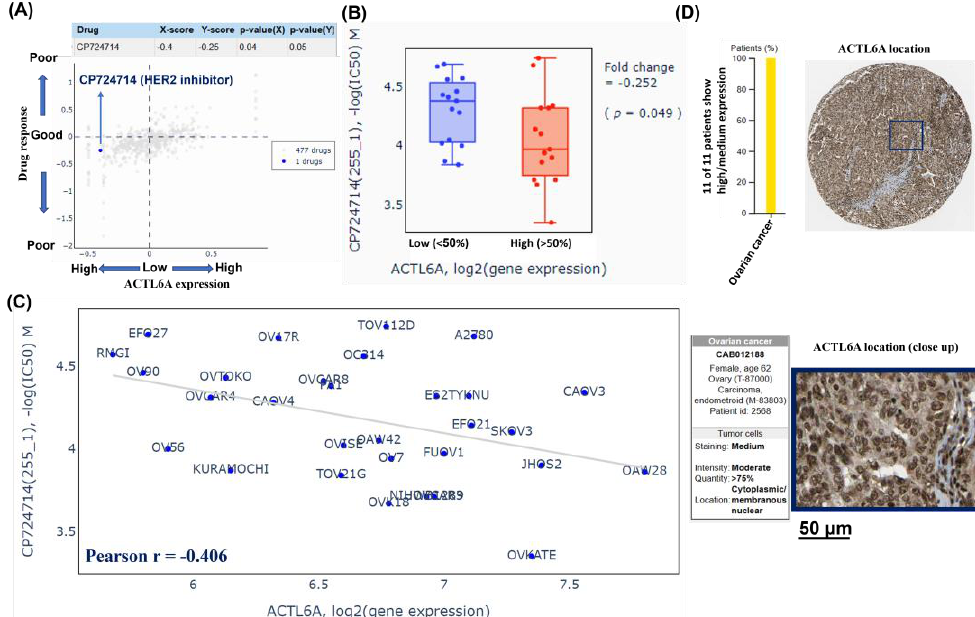
Figure 4. CP724714 as a therapeutic option in the context of high ACTL6A in ovarian cancer. Q-omics analysis was used to analyze cross-association scores for the identification of candidate drugs acting on ovarian cancer cells based on ACTL6A expression. ( A ) X-score: log(fold-change) of ACTL6A expression between samples of high and low response of target drug. Y-score: log(fold-change) of target drug response between samples of high and low ACTL6A expression. The blue dot hits a negative association with p -value(X) < 0.05 and p -value(Y) < 0.05. ( B ) The boxplots of −log (half maximal inhibitory concentration (IC50)) M of CP724714 in low (<50%) and high (>50%) ACTL6A expression. Fold-change: the difference of IC50 variable between low (<50%) and high (>50%) ACTL6A expression ( C ) The scatter plot showed that ACTL6A expression levels and IC50 of